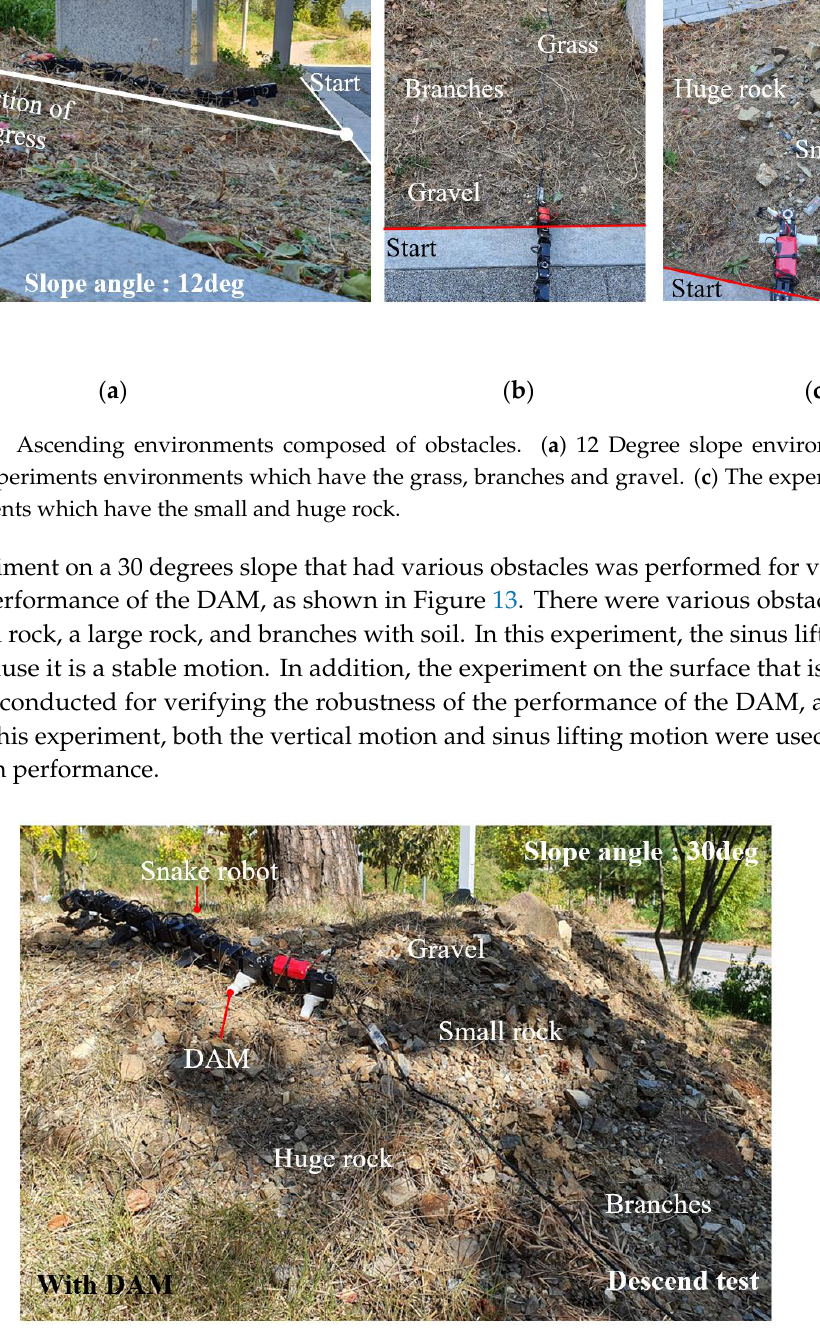
Figure 14. Gravelly field for testing the robustness of the performance of the DAM. 3. Results 3.1. Experiment Results of Slope Condition A graph comparing the theoretical values with experiment values is shown in Figure 15. The maximum error between the theoretical values and the experiment values was 49% when the DAM length was 12 cm, and the minimum error value was 25% when the DAM length was 18 cm. As the length of the DAM increased, the maximum slope angle increased. The theoretical values and the experiment values were compared using a trend line and the method of least squares. As a result of the least squares method, the gradient of the theoretical values’ trend line was 5.4, and the gradient of the experiment values’ trend line was 6.8. It can be confirmed that the error of the ratio of the maximum slope angle was 20.6%.